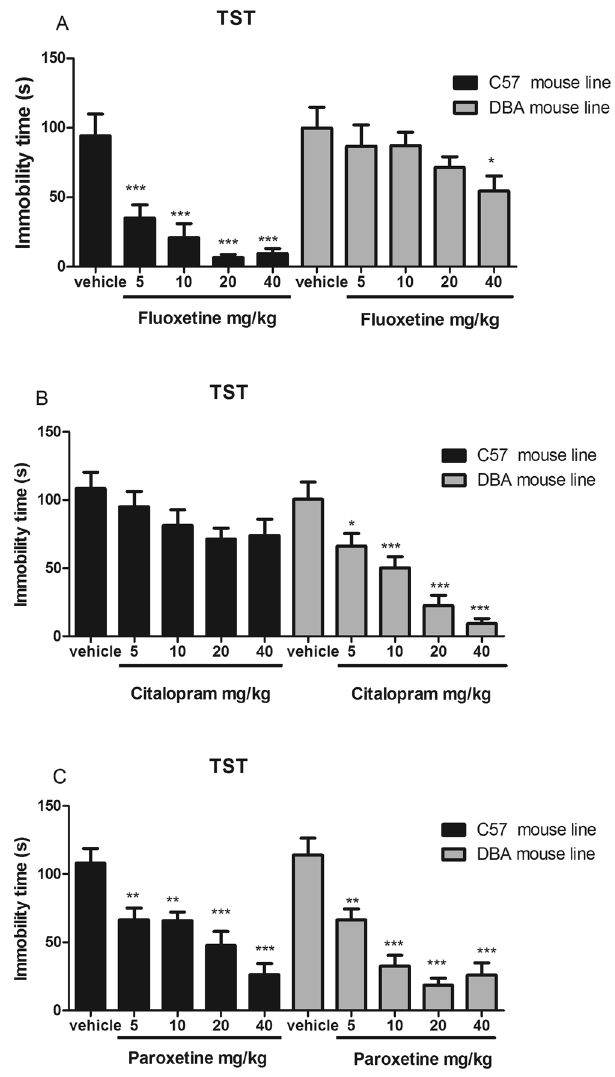
Figure 1. Effects of fluoxetine ( A ), citalopram ( B ) and paroxetine ( C ) on immobility time in the tail suspension test in DBA/2J and C57BL/6J mice. All tests were performed 30 min after i.p. injection of 5, 10, 20, or 40 mg/ kg drug. Data are presented as the mean ± S.E.M. (n = 8–10/group). * p < 0.05, ** p < 0.01, *** p < 0.001 versus